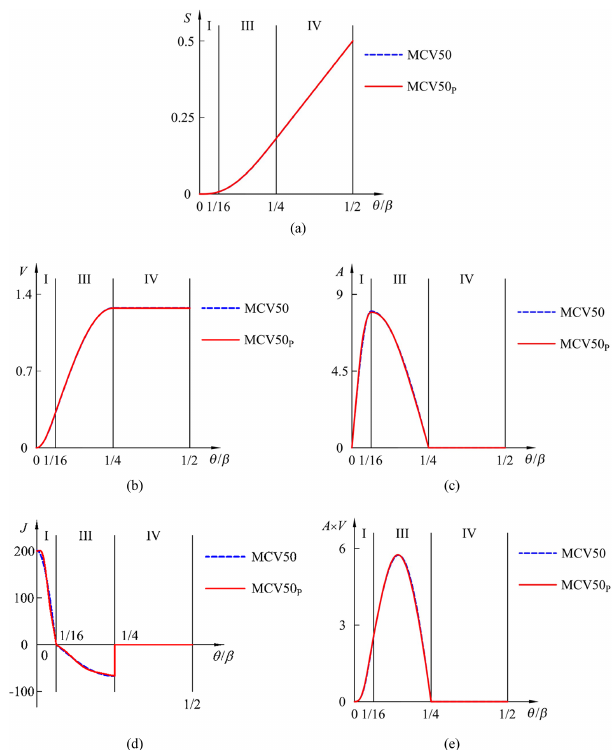
Figure 11. Variation in normalized motion program in Example 4.